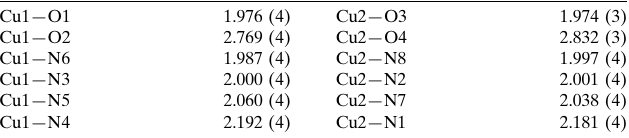
Selected bond lengths (A˚ ).